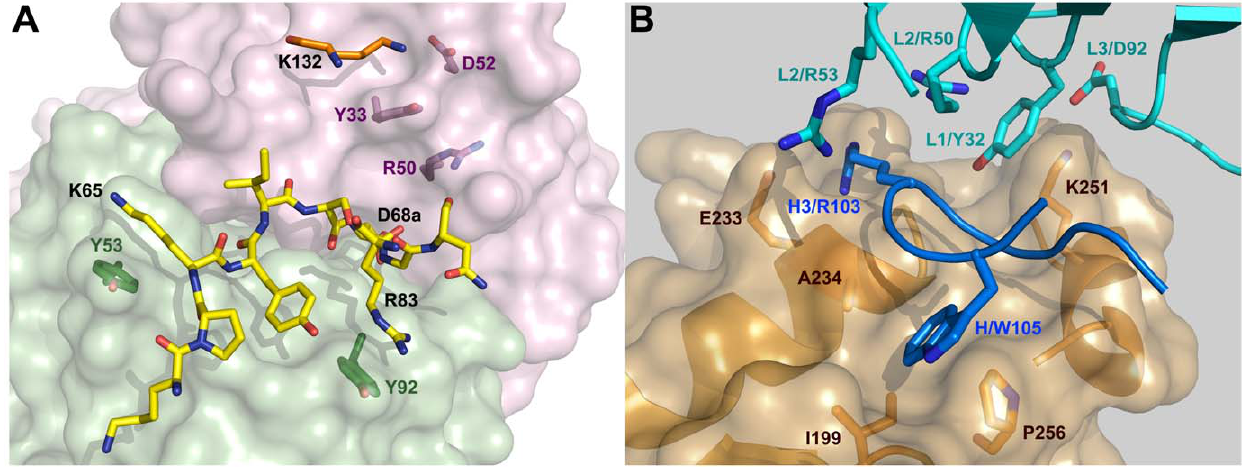
Figure 4. Rational design for mutagenesis. A) Principal residues involved in the the mAb 7C11 epitope on the N-terminal lobe of Bla g 2. The longest consecutive part of the epitope (shown in yellow) interacts with all three CDR of the light chain (surface in green) and has 9 residues (starting at 60) from which two were mutated to alanine (K65 and D68a). K65, R83 and K132 form cation- p interactions with tyrosines Y53, Y92 and Y33 from the mAb 7C11, respectively. The heavy chain of the antibody is shown in lilac. B) Main residues involved in the mAb 4C3 epitope on the C-terminal lobe of Bla g 2. The surface of the allergen, with the main residues involved in antibody binding is shown in gold. The third loop of the heavy chain of the antibody (in blue) includes: a) R103 attracted to the negatively charged E233, and b) W105 that docks into a hydrophobic pocked formed by A234, I199 and P256 in Bla g 2. Residues K251 and Y32 involved in a cation- p interaction are also shown.